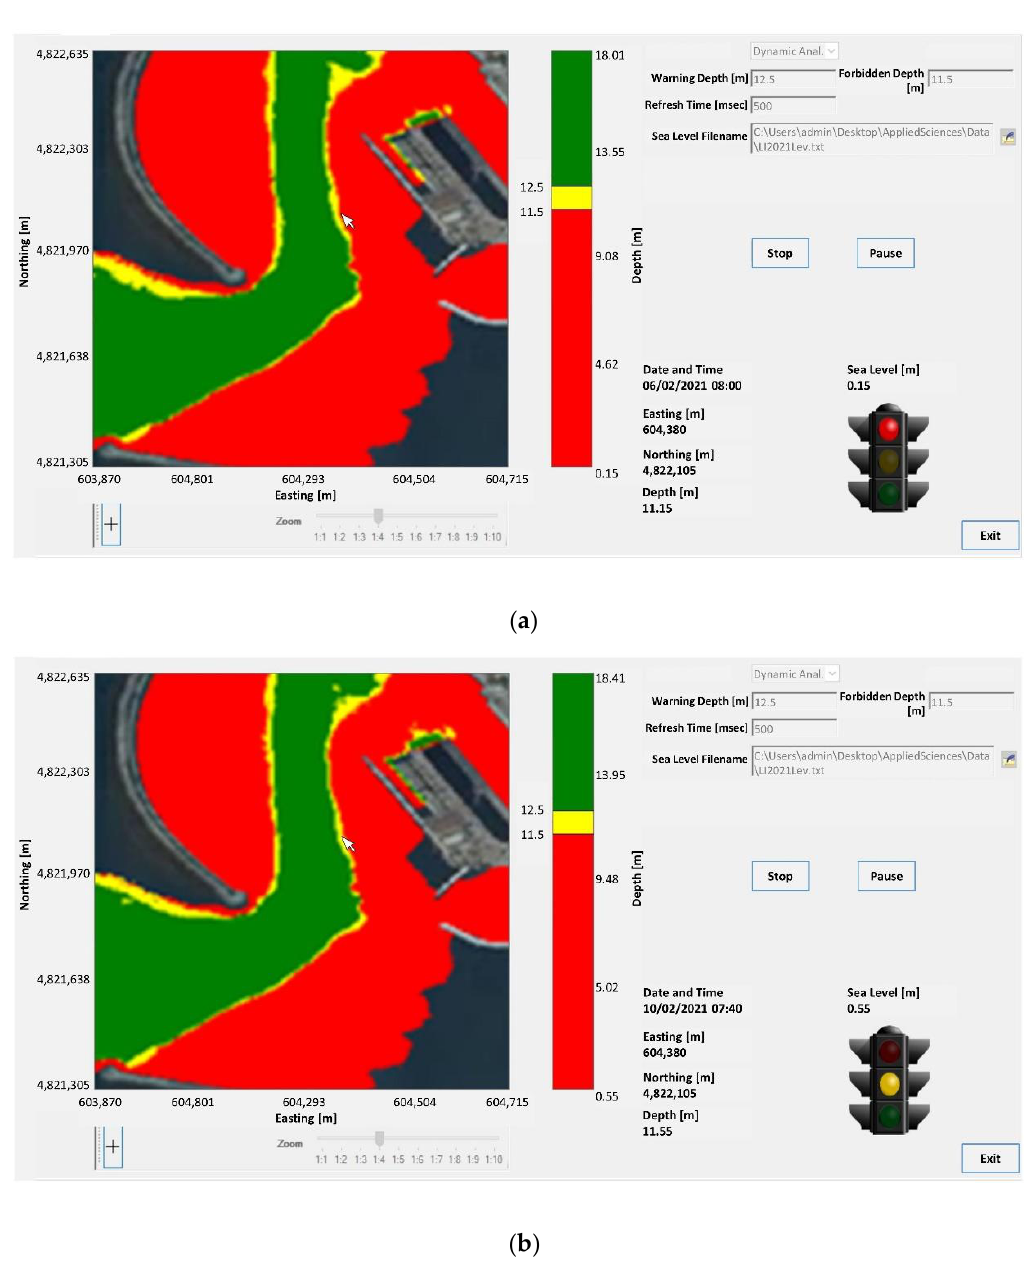
Figure 16. Detail of virtual traffic lights in the port of Livorno: ( a ) on 6 February 2021 at 08:00; ( b ) on 10 February 2021 at 07:40; thresholds equal to 11.5 and 12.5 m.